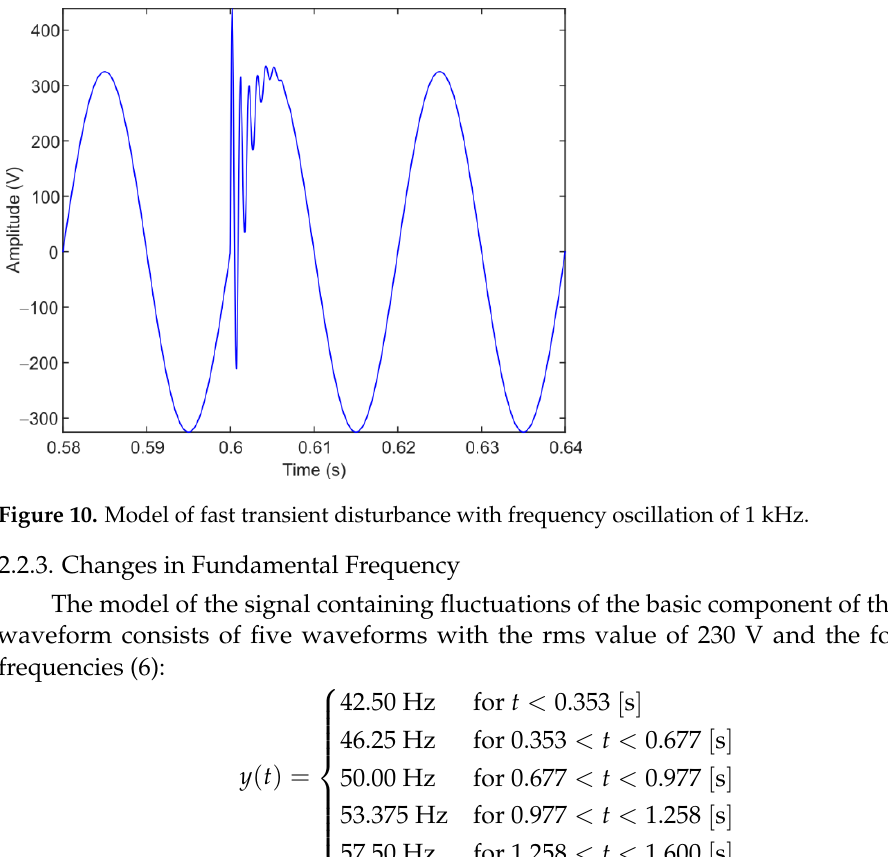
Figure 9. Model of fast transient disturbance with frequency oscillation of 1 MHz: ( a ) power signal and ( b ) expanded disturbance.